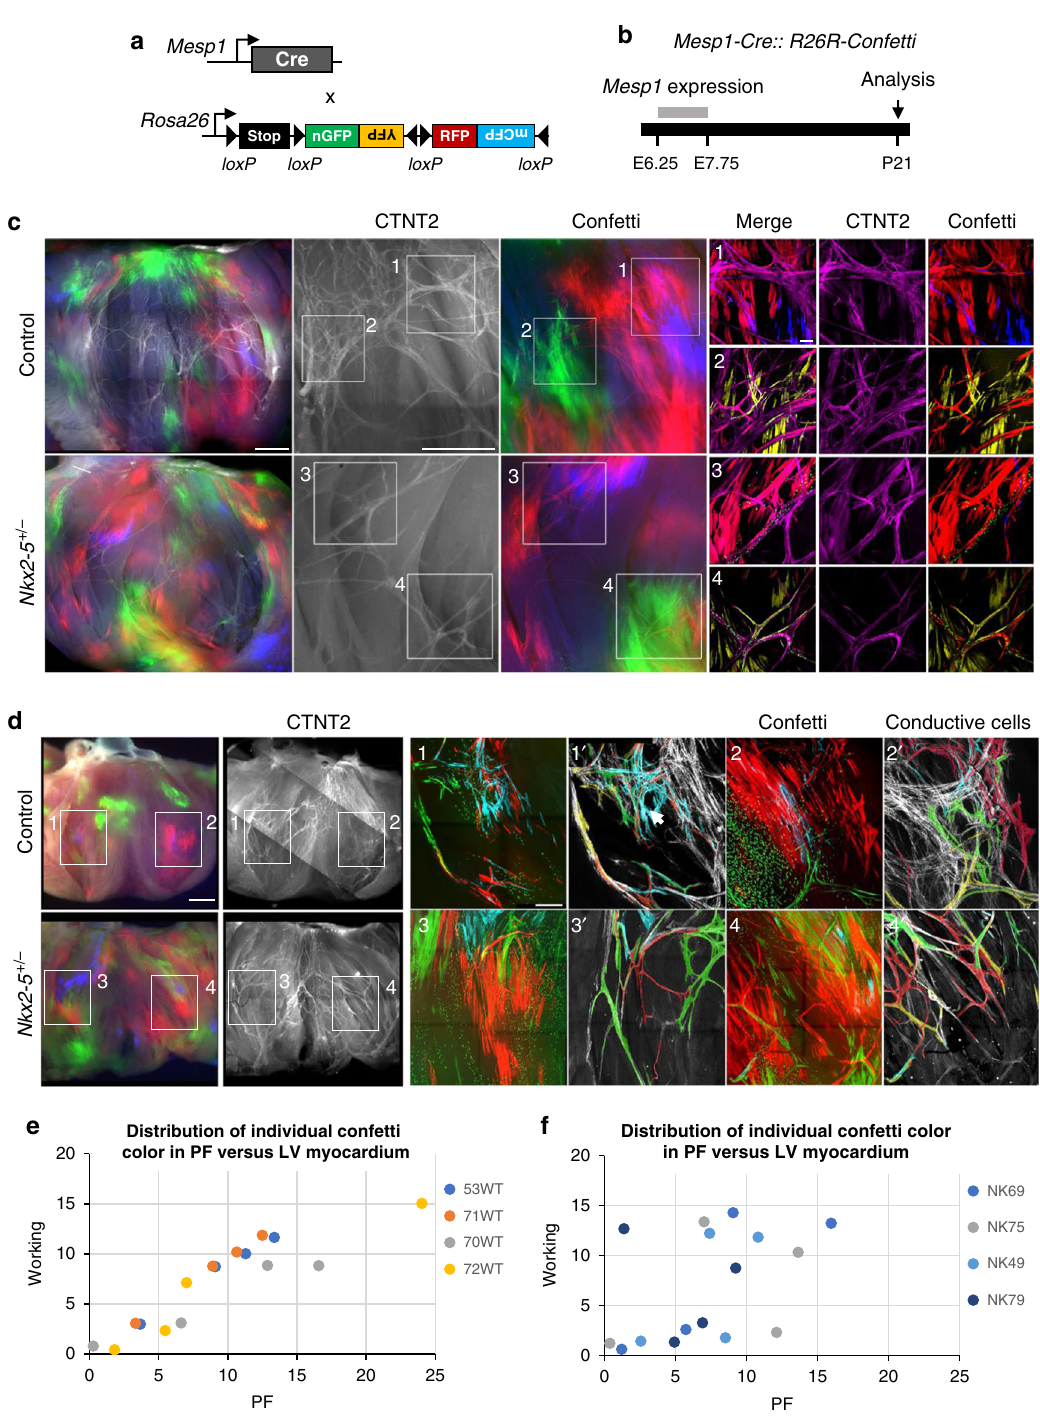
Fig. 4 Mosaic tracing analysis of Mesp1 + early cardiac progenitors. a Scheme illustrating the genetic tracing strategy using R26R-Confetti multicolor reporter mouse line crossed with non-inducible Mesp1-Cre mice. b Recombination of the confetti allele occurs during the short time-window of Mesp1 expression, between E6.25 and E7.75. Mosaic tracing analysis in control and Nkx2-5 + / − mice is performed at P21. c Whole-mount fl uorescence views of Mesp1-Cre::R26R-Confetti opened-left ventricles at P21. Immunostaining for Contactin-2 (CNTN2) is used to label the mature PF network. Small panels (1 – 4) show high magni fi cation confocal images of different PF network regions. Scale bars = 1 mm and 100 µ m in insets. d Small panels (1 – 4) show high magni fi cation confocal images of the PF network. Panels (1 ′ – 4 ′ ) are image reconstructions in which conductive only confetti + cells are manually drawn. Non-conductive confetti + cells are not represented. In control hearts, conductive confetti + cells form either small or large monochromatic clusters. Large clusters (arrows) contribute to complex parts of the PF network. In Nkx2-5 + / − hearts, only small clusters contribute to the hypoplastic network. Scale bars = 1 mm and 200 µ m in insets. e and f Dot plots of individual Mesp1 + c onfetti colors showing percentage contribution to the working myocardium versus PF network in control (WT) or Nkx2-5 + / − (NK)